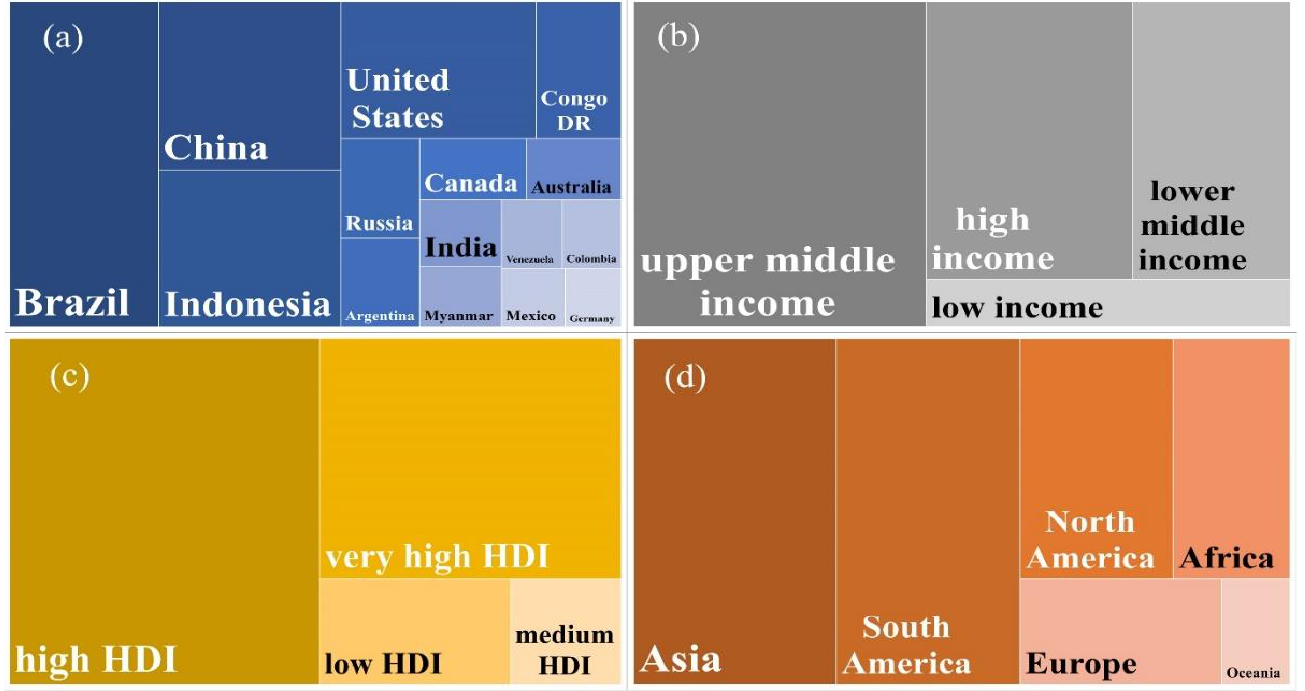
Figure 1. Allocating distribution of cumulative overshoot of GHG emissions from food systems (1990–2018). GHG emissions from ( a ) 15 countries, ( b ) four income groups (as per World Bank), ( c ) four HDI categories (as per HDR, 2020), and ( d ) six continents.